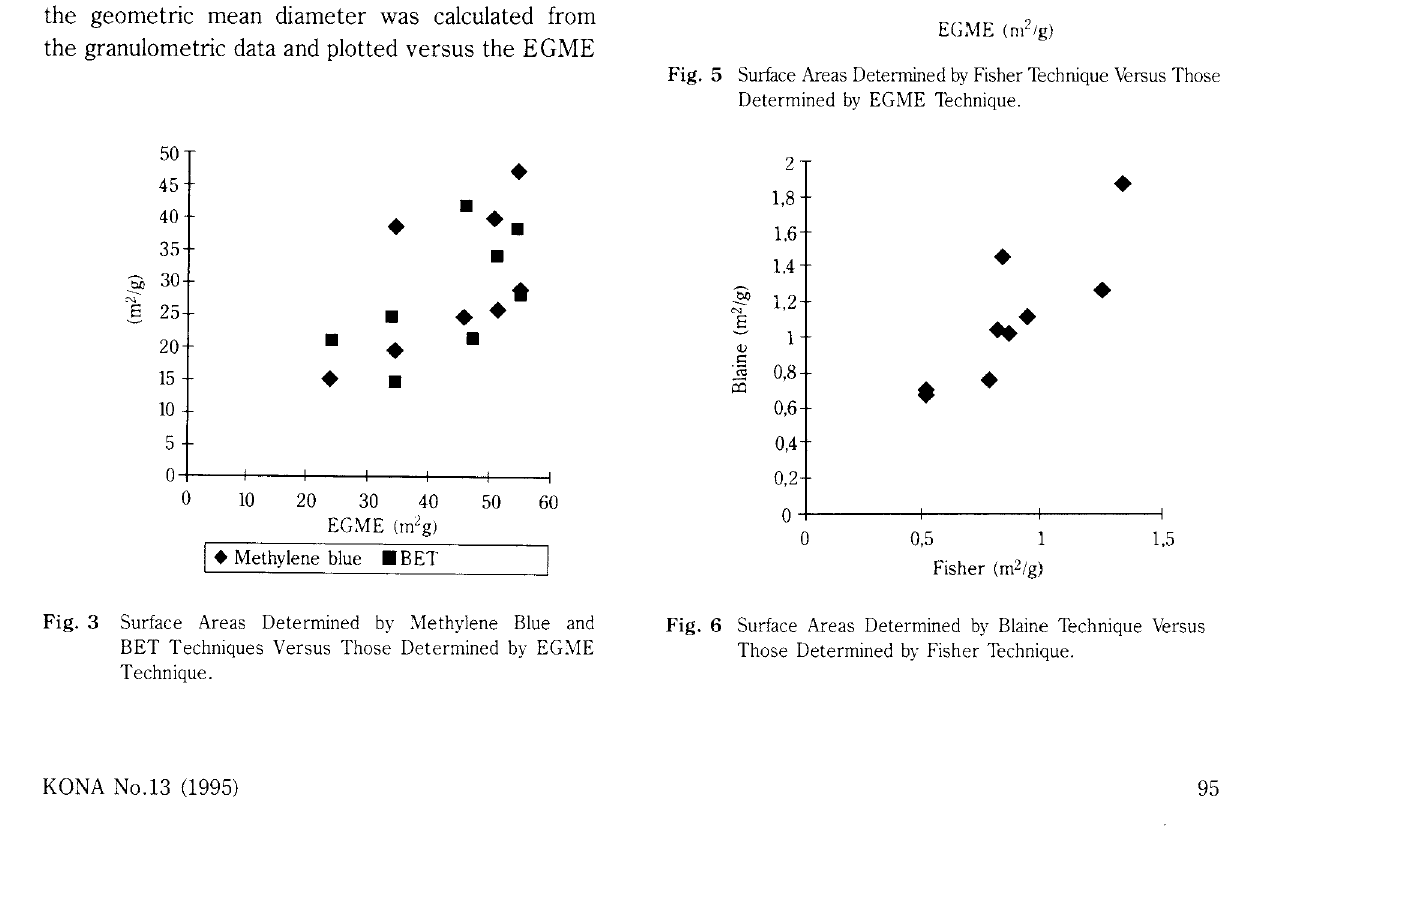
Fig. 5 Surface Areas Determined by Fisher Technique Versus Those Determined by EGME Technique.